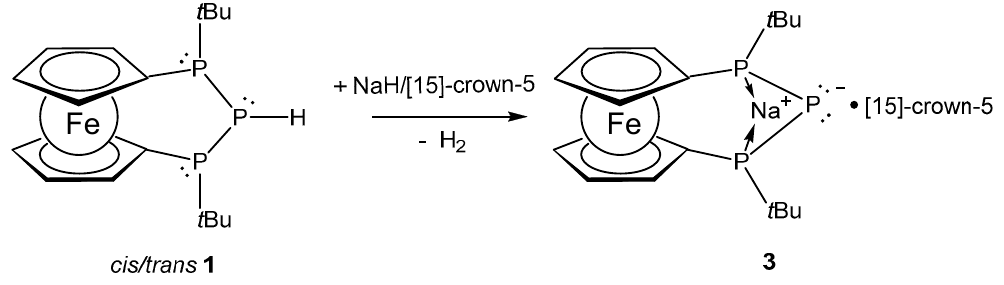
Figure 2. ORTEP plot of the molecular structure of 2 ( left ), and expansion of the folded P 3 Li ring ( right ). Ellipsoids were drawn at the 30% probability level. Hydrogen atoms were omitted for clarity.